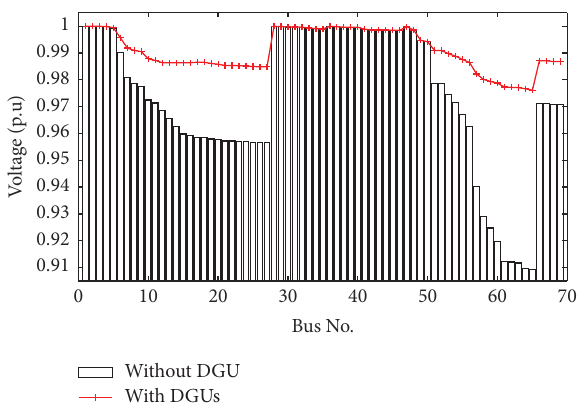
Figure 15: Voltage profle of the IEEE 69-bus system before and after DGUs connection.